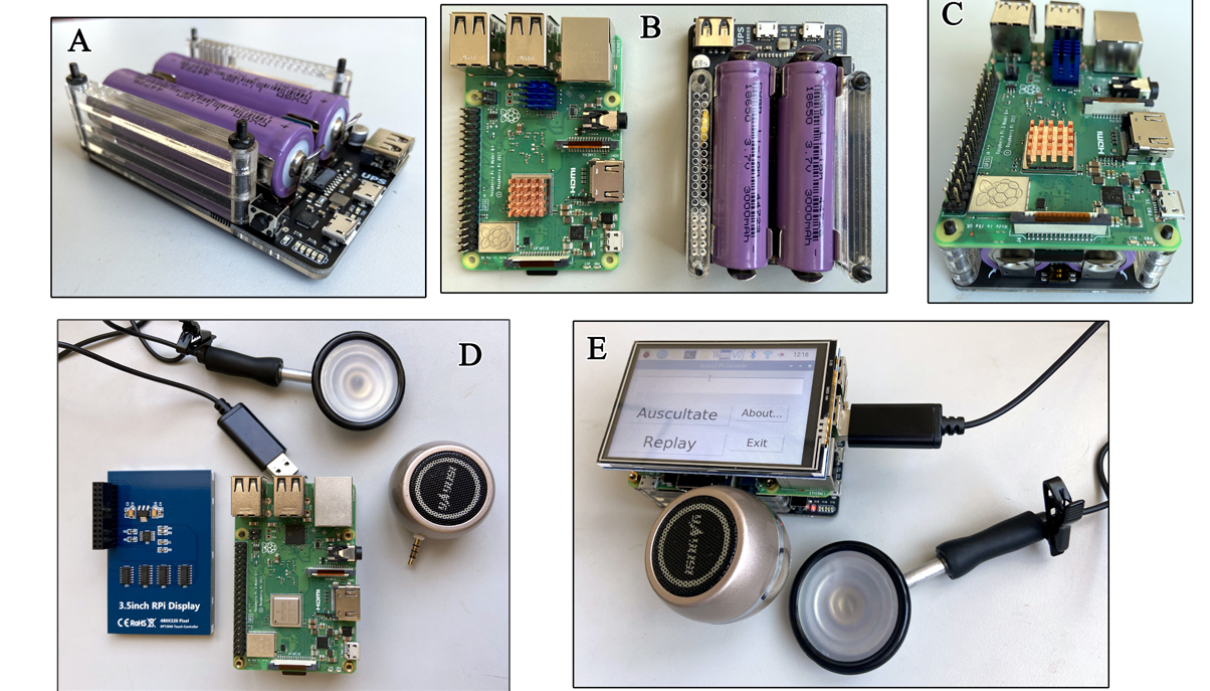
Figure 4. The Auscul Pi prototype. (A) The uninterruptible power supply. (B) The Raspberry Pi system (left) and uninterruptible power supply (right). (C) Combination of the Raspberry Pi and the power supply. (D) A microphone connected to the chest piece from a conventional stethoscope, 3.5-inch touch screen, Raspberry Pi with power supply, and microspeaker. (E) Fully assembled device containing the components in D.